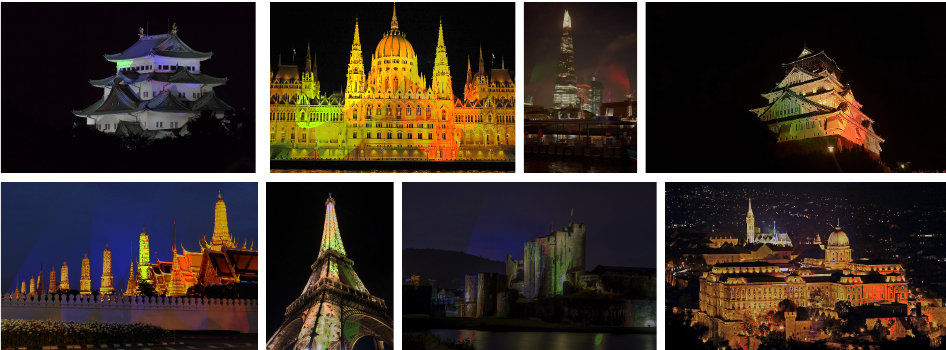
Figure 16. Rendering results with directional diffusion (JBF).